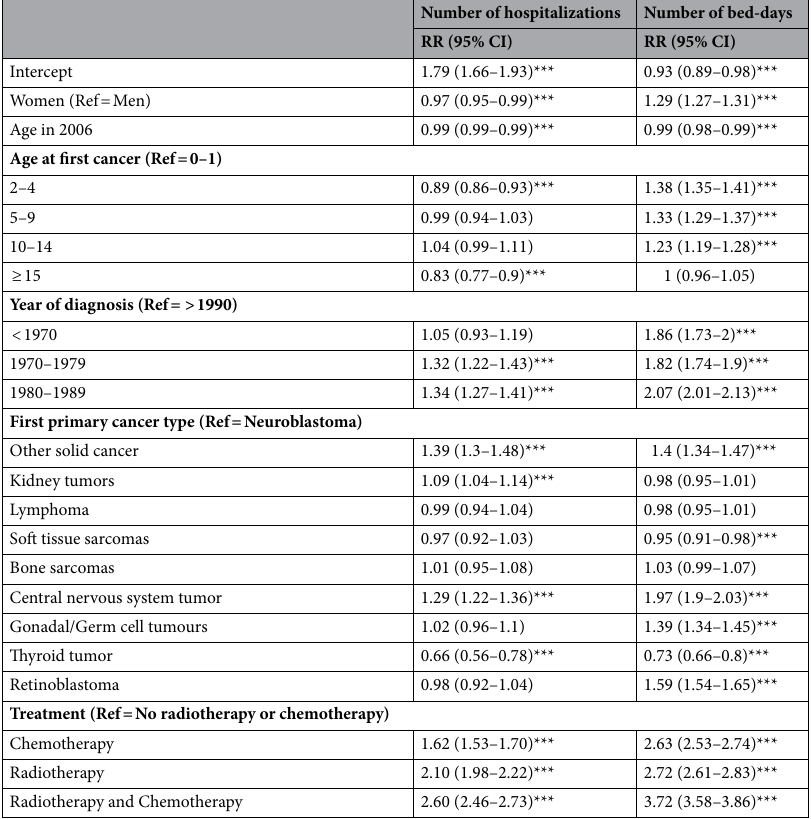
Table 3. Multivariate analysis of the total number of hospitalizations and bed-days. RR, risk ratio; CI, confidence interval. ***p < 0.01, **p <